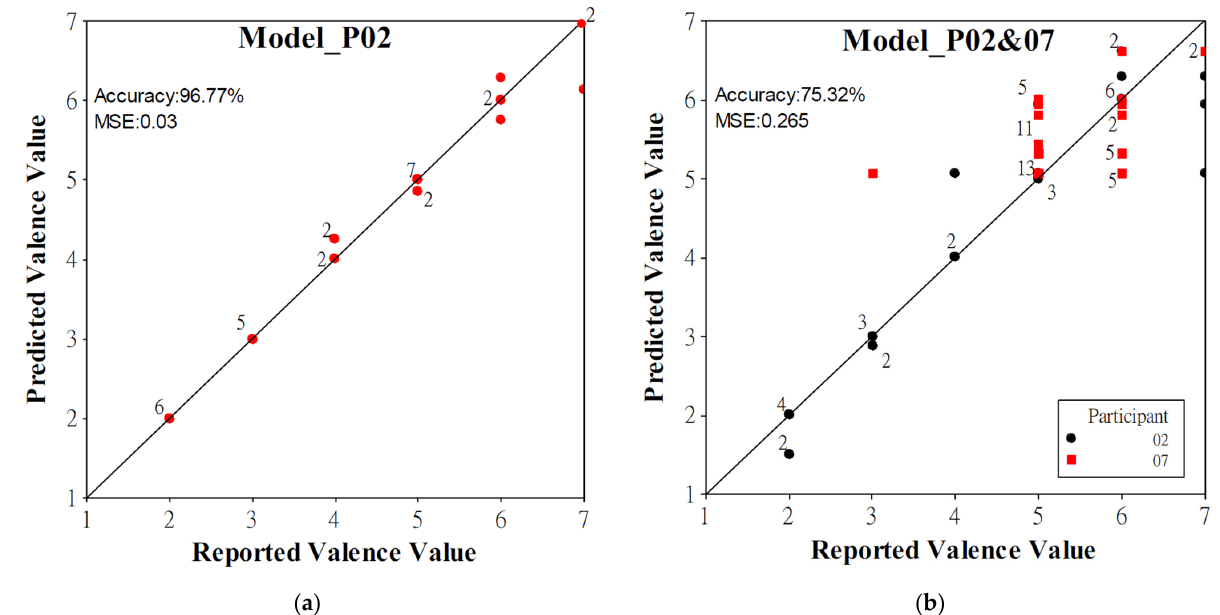
Figure 6. Visualization of model performance. ( a ) Performance of Model_P02 using 98 correlation-screened features (70% modeling, 30% testing); ( b ) performance of Model_P02&07 using 98 correlation-screened features (70% modeling, 30% testing). The number on the symbols represents the number of data with the same predictions.